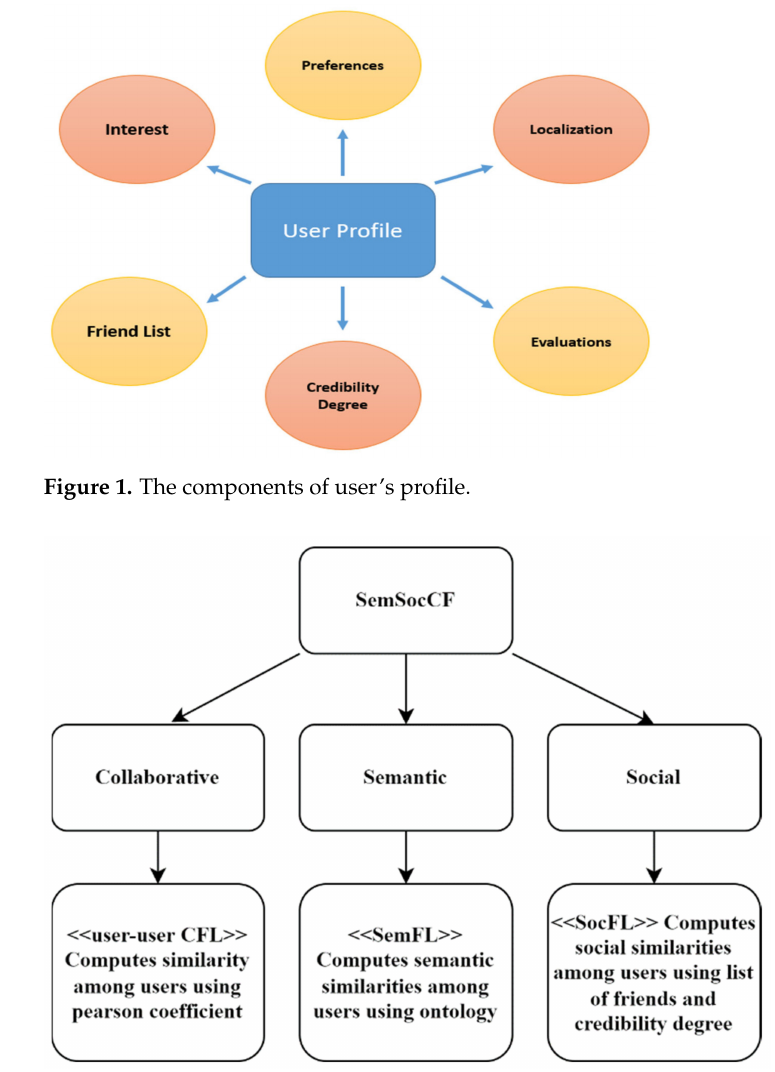
Figure 2. The combination of social-based CoF and semantic